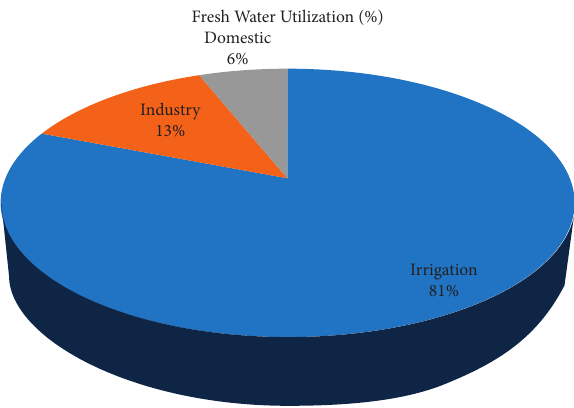
Figure 1: Fresh water utilization